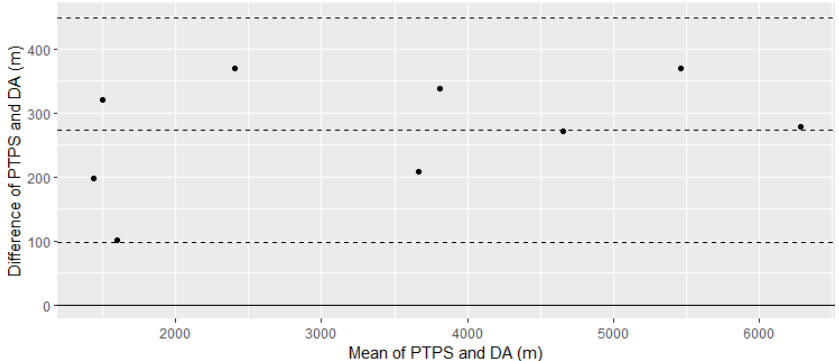
Figure 1. Bland–Altman plot comparing Polar Team Pro sensors and desktop analysis. Key: PTPS, Polar Team Pro sensor; DA, desktop analysis; middle dashed line, mean difference between PTPS and DA; upper dashed line, +1.96 SD from mean difference; lower dashed line, − 1.96 SD from mean difference. Table 2. Average distance per week per class during academy